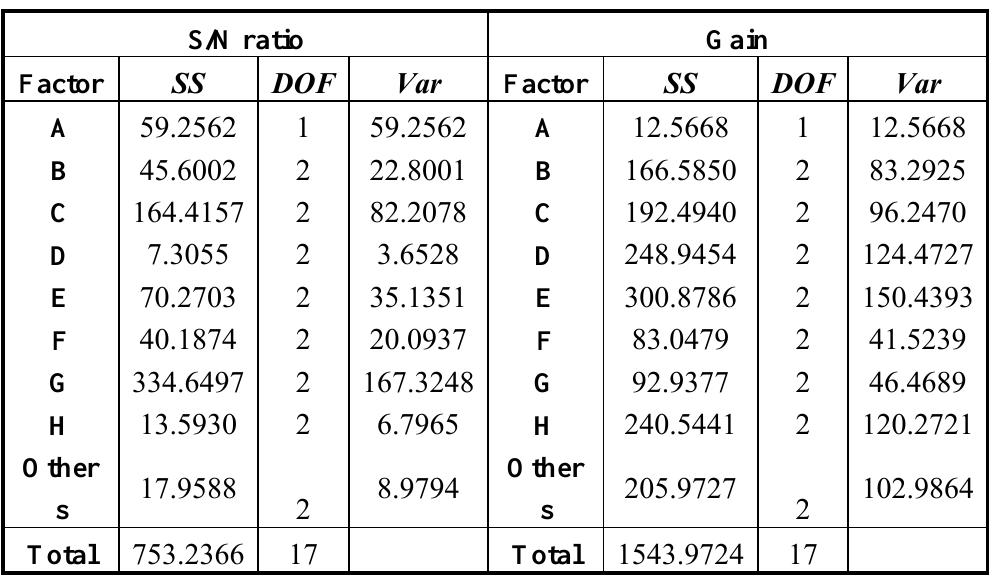
Table 5. The results of